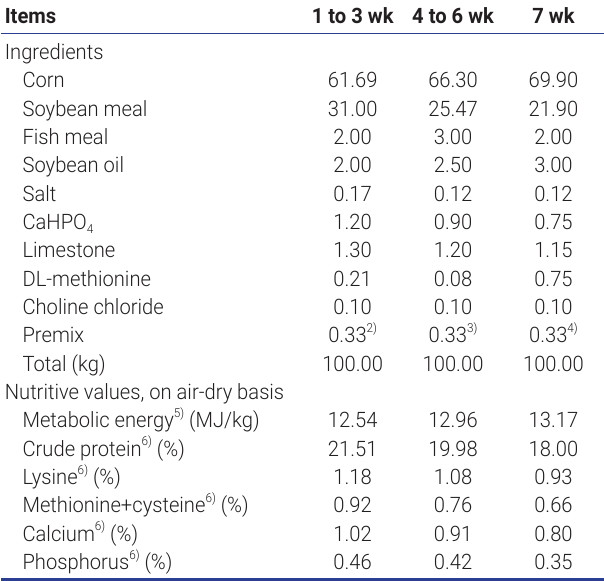
Table 2. Composition (kg/100 kg) of diets 1) for broiler breeders’ off- spring Items 1 to 3 wk 4 to 6 wk 7 wk